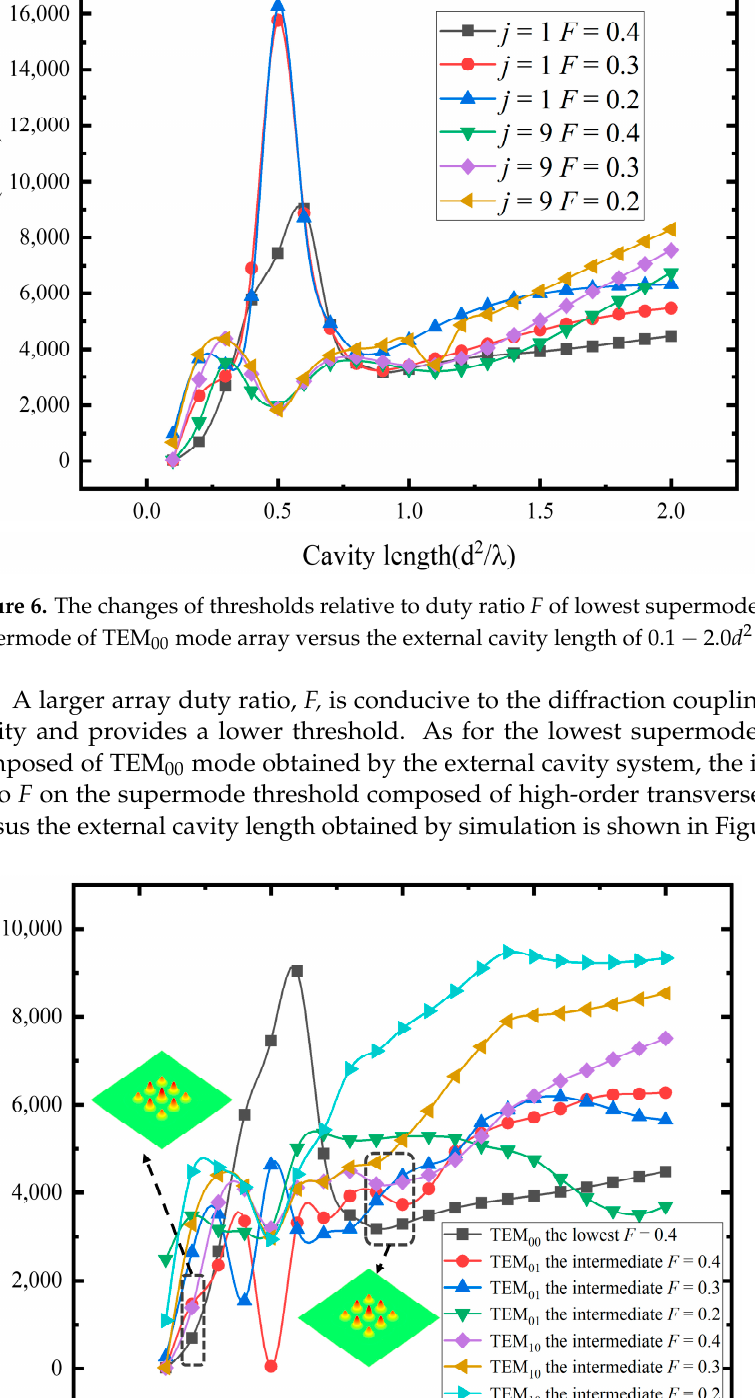
lowest supermode threshold of the TEM 00 array versus the external cavity length from 0.1 − 2.0 d 2 / λ